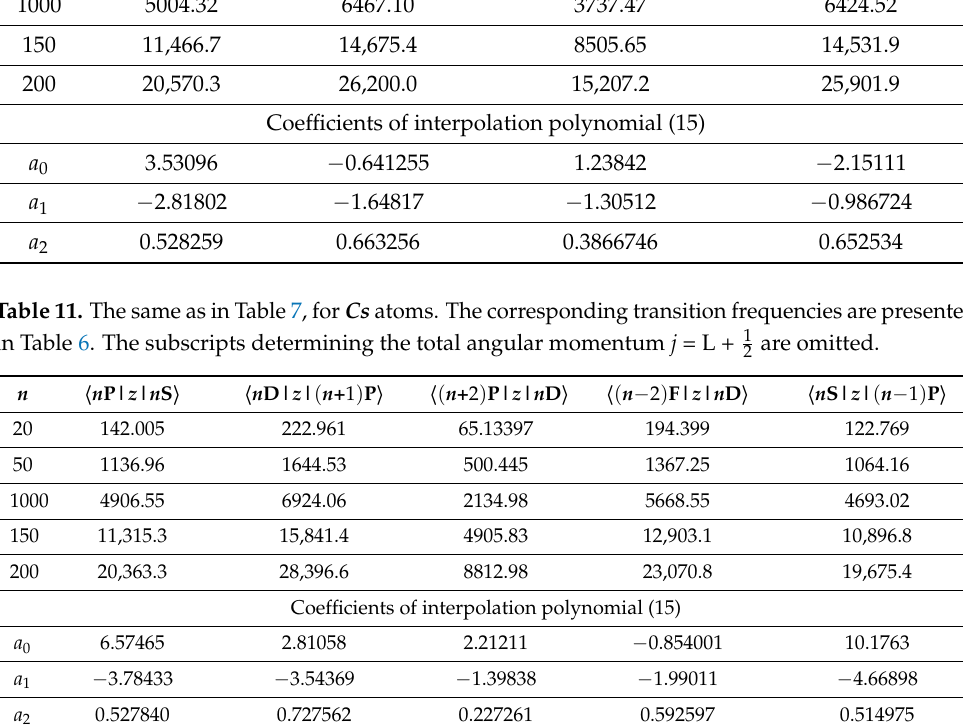
Table 10. The same as in Table 7, for Rb atoms. The corresponding transition frequencies are presented in Table 5.